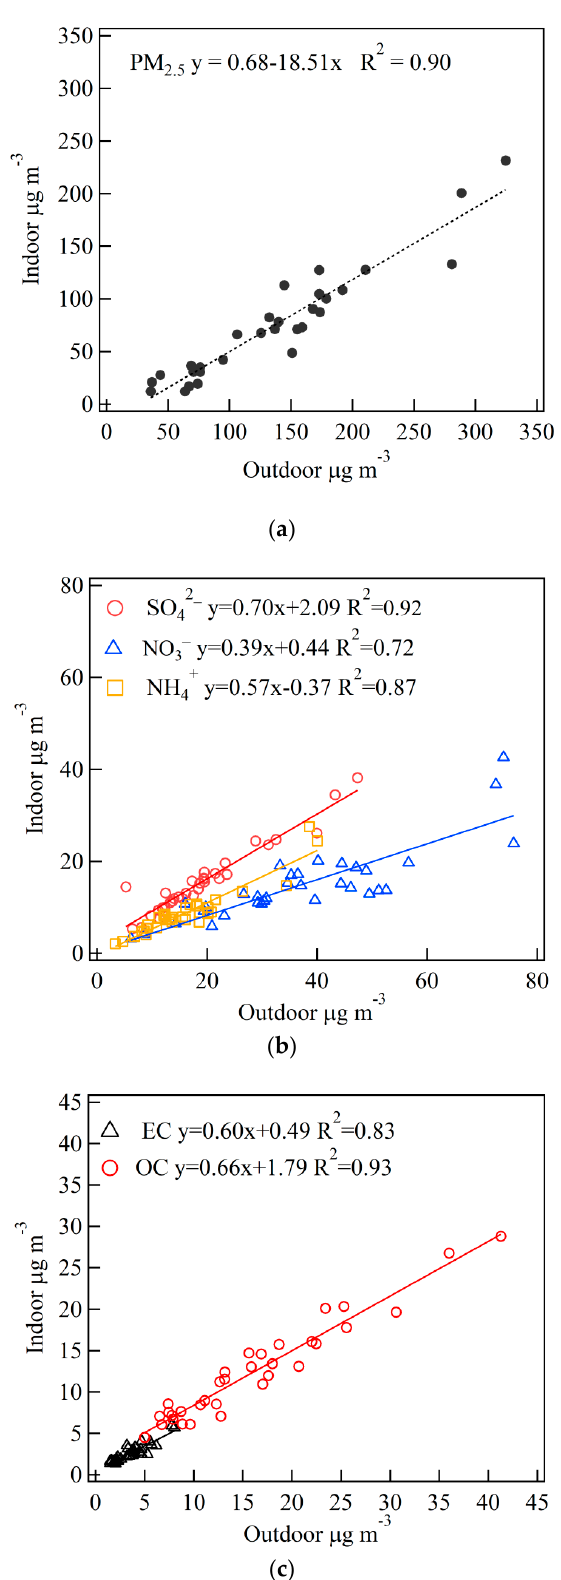
Figure 5. Linear regression between indoor and outdoor: ( a ) PM 2.5 ; ( b ) SO 4 2 − , NO 3 − , and NH 4 + ; ( c ) OC and EC.